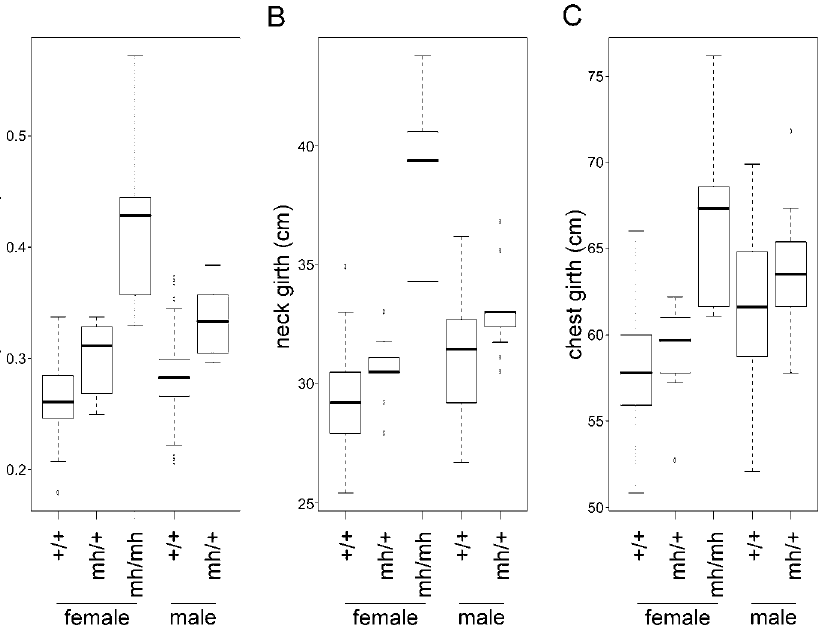
Figure 3. Variation in Musculature among Whippets of the Three Potential Genotypes Whippets homozygous for the cys ! stop mutation have a higher mass-to-height ratio (A), a larger neck girth (B), and larger chest girth (C) than wild- type or heterozygous individuals. Males and females are shown separately. þ / þ , wild-type individuals; mh/ þ , individuals heterozygous for the cys ! stop mutation; and mh/mh, individuals homozygous for the cys ! stop mutation. The center bar indicates the median value and the top and bottom edges of the box delimit the 75th and 25th percentiles, respectively.